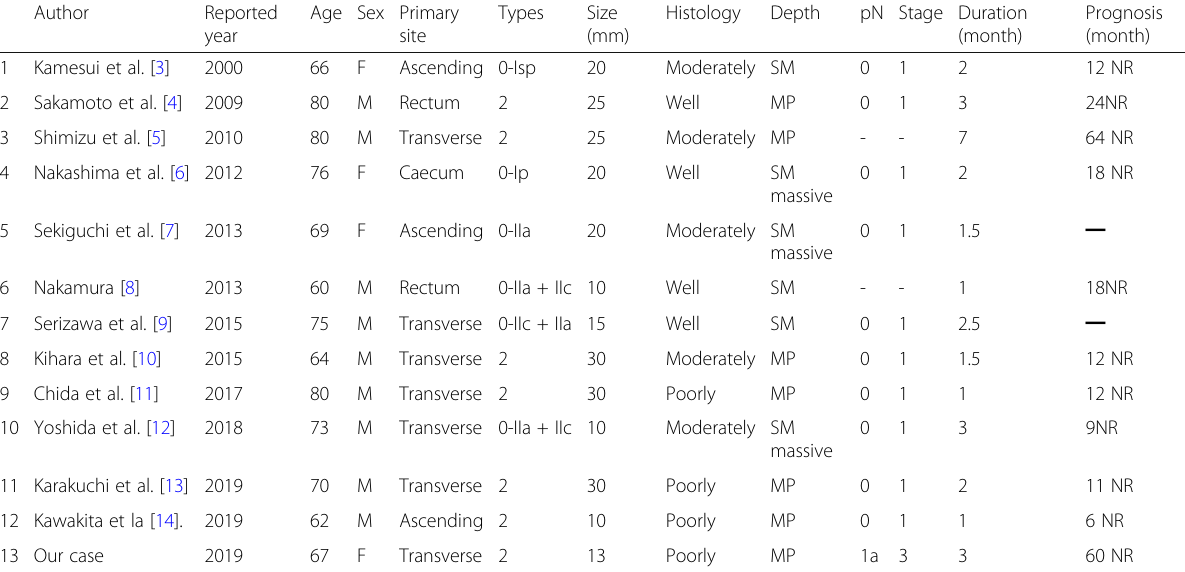
Table 1 Reported cases of spontaneous regression of colorectal cancer in Japan